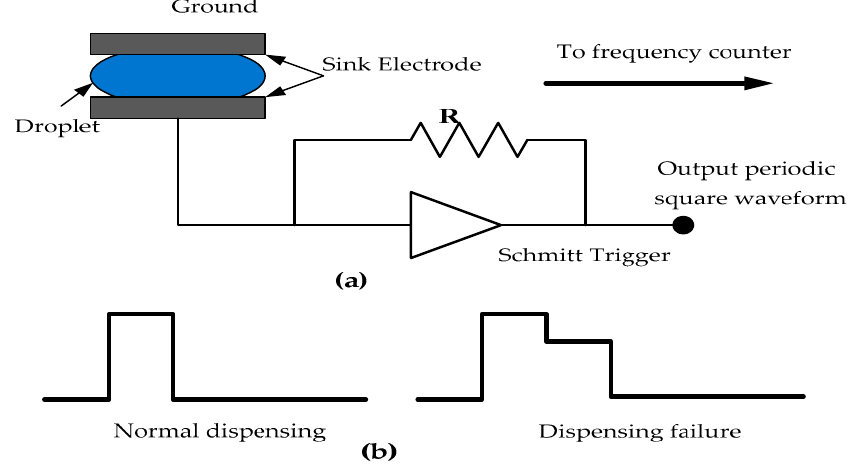
Figure 5. Functional testing ( a ) capacitive sensing circuit with droplet in the sink electrode ( b ) test readouts from the sensing circuit for the defect detection in DMFBs [38].